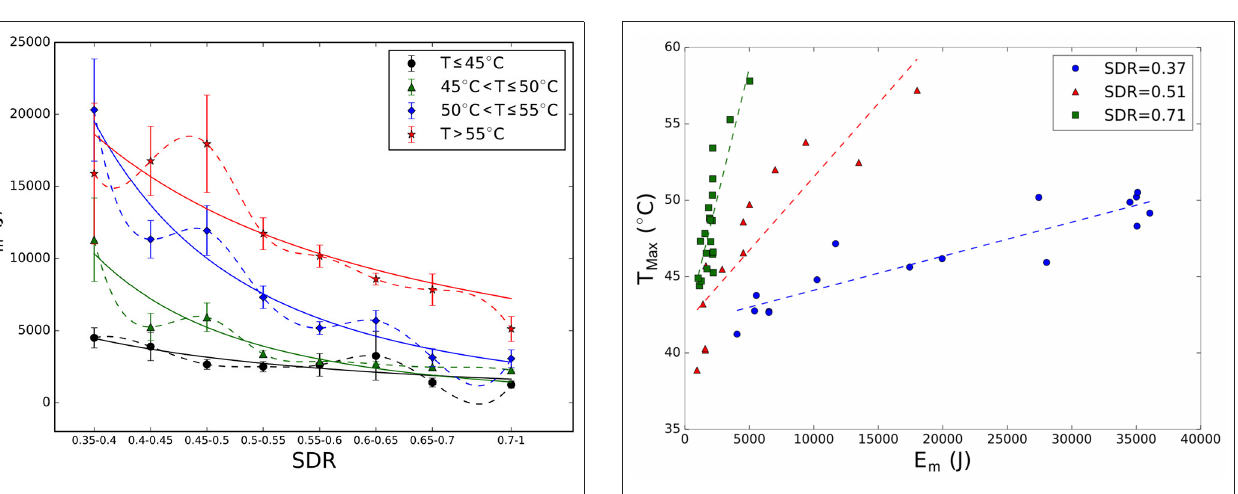
FIGURE 2 | Maximum peak temperature (Tmax) as a function of measured energy (Em) for three patients with different skull density ratio (SDR) values (blue 0.37; red 0.51; green 0.71). Each marker represents a different sonication process. Dashed line represents the best fit linear curve for each